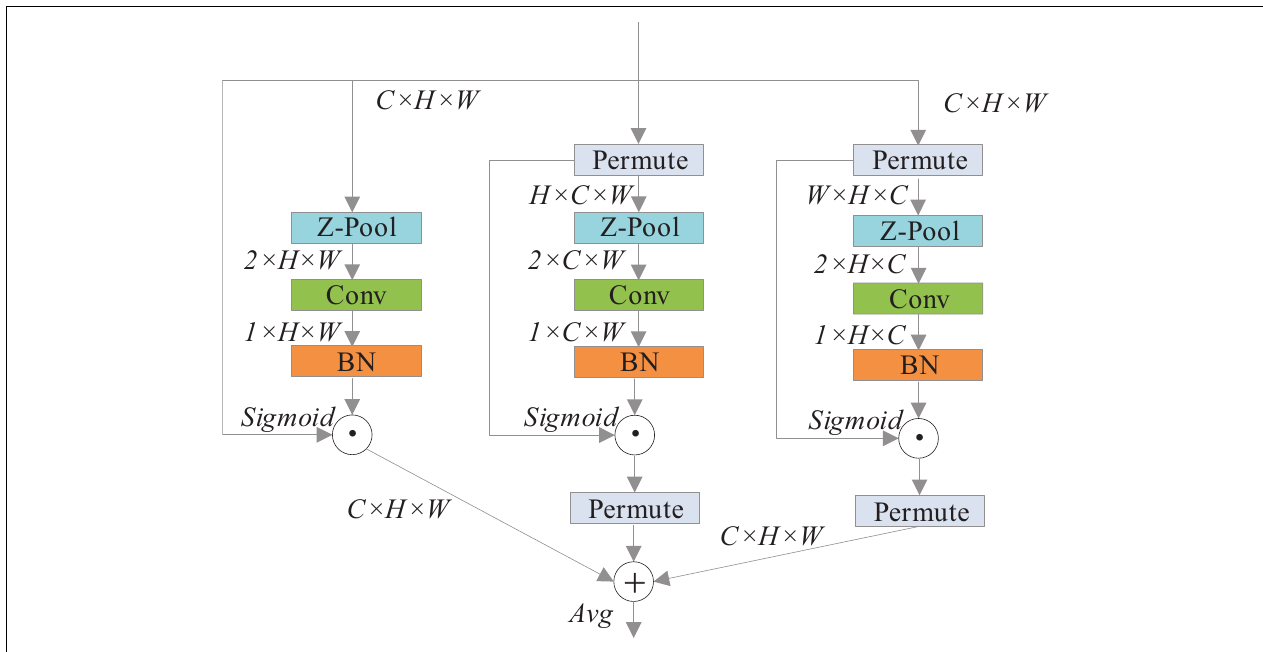
FIGURE 1 | Network structure diagram of triplet attention (Song et al., 2018).